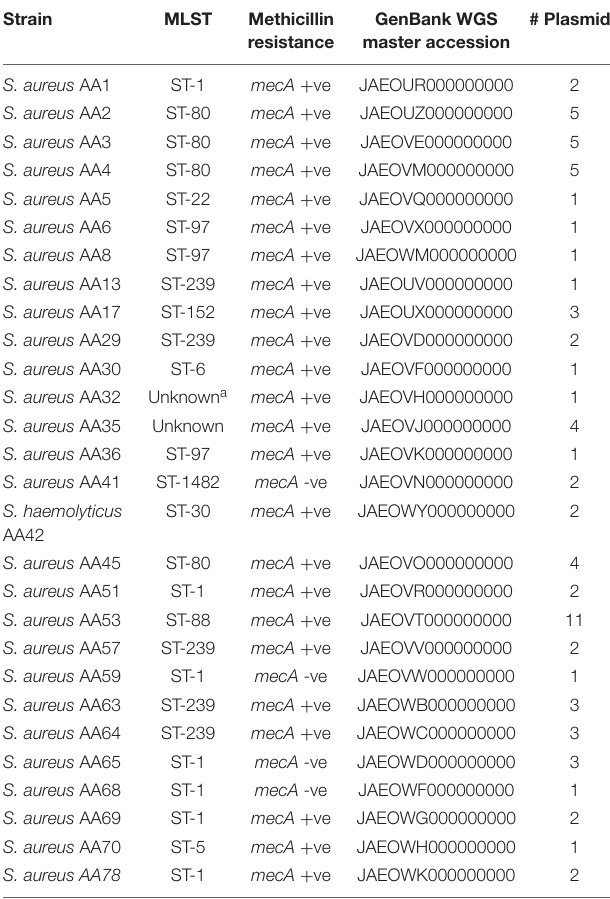
TABLE 1 | List of Egyptian S. aureus and S. haemolyticus strains harboring